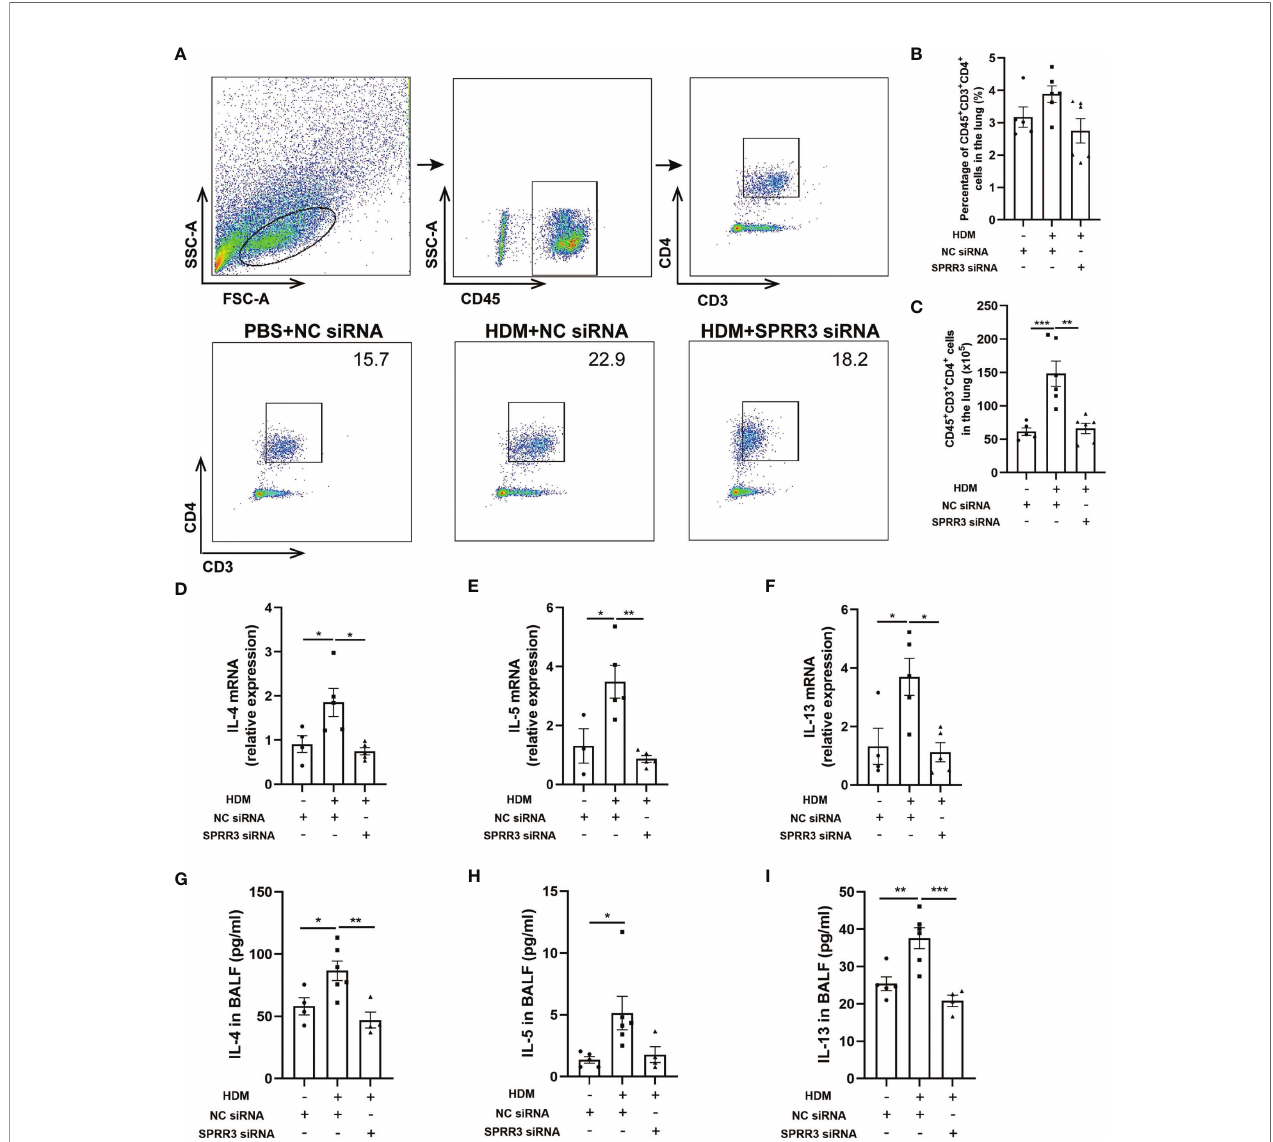
FIGURE 6 | SPRR3 is involved in Th2 immune responses in the house dust mite (HDM)-induced asthma model. (A) Gating strategy to identify CD4 + T cells in mouse lungs, cells can be separated in CD45 + and CD45 − cell populations. Gating for CD4 + T cells (CD3 + CD4 + ) within the CD45 + cell population. (B) The percentage of CD4 + T cells in the lung. (C) The counts of CD4 + T cells in the lung. (D – F) The mRNA expressions of IL-4, IL-5, and IL-13 measured using quantitative PCR. (G – I) The protein levels of IL-4, IL-5, and IL-13 in bronchoalveolar lavage fl uid (BALF) determined by ELISA. Values represent mean ± SEM, n = 4 – 6 for each group. * p < 0.05, ** p < 0.01, *** p <